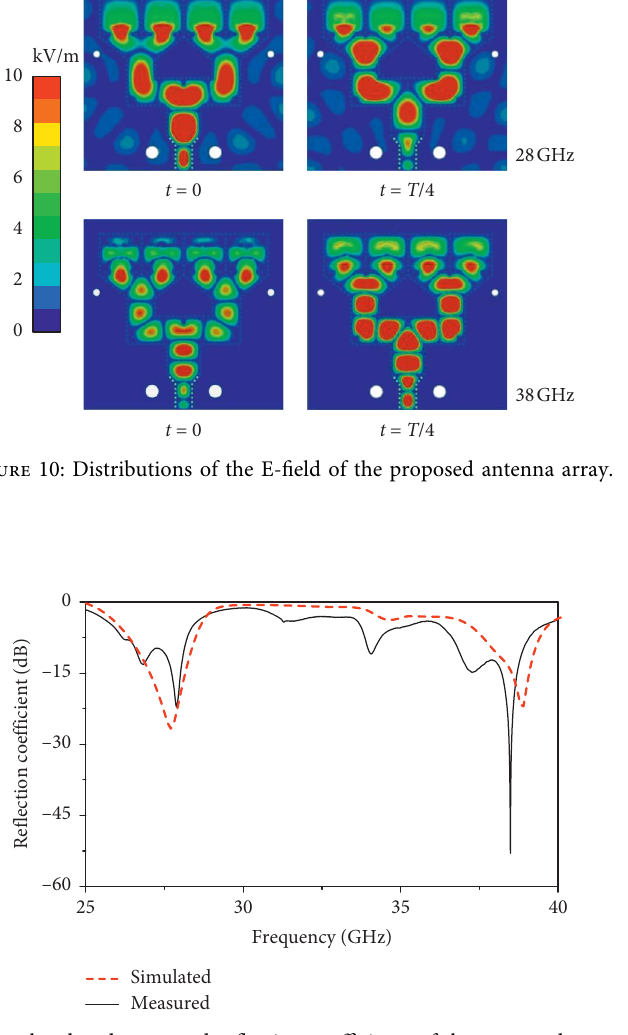
Figure 11: Simulated and measured refection coefcients of the proposed antenna array.